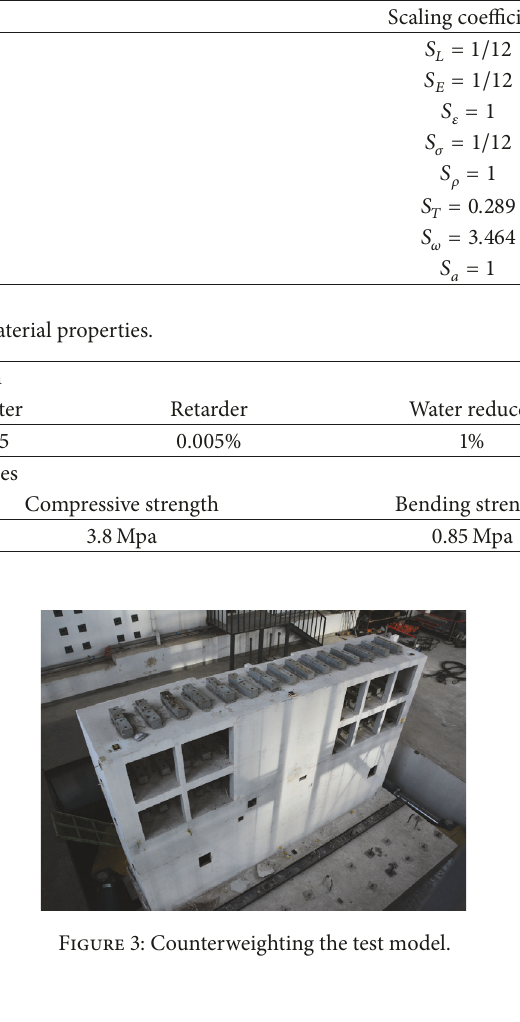
Table 1: Detailed similarity coefficients.